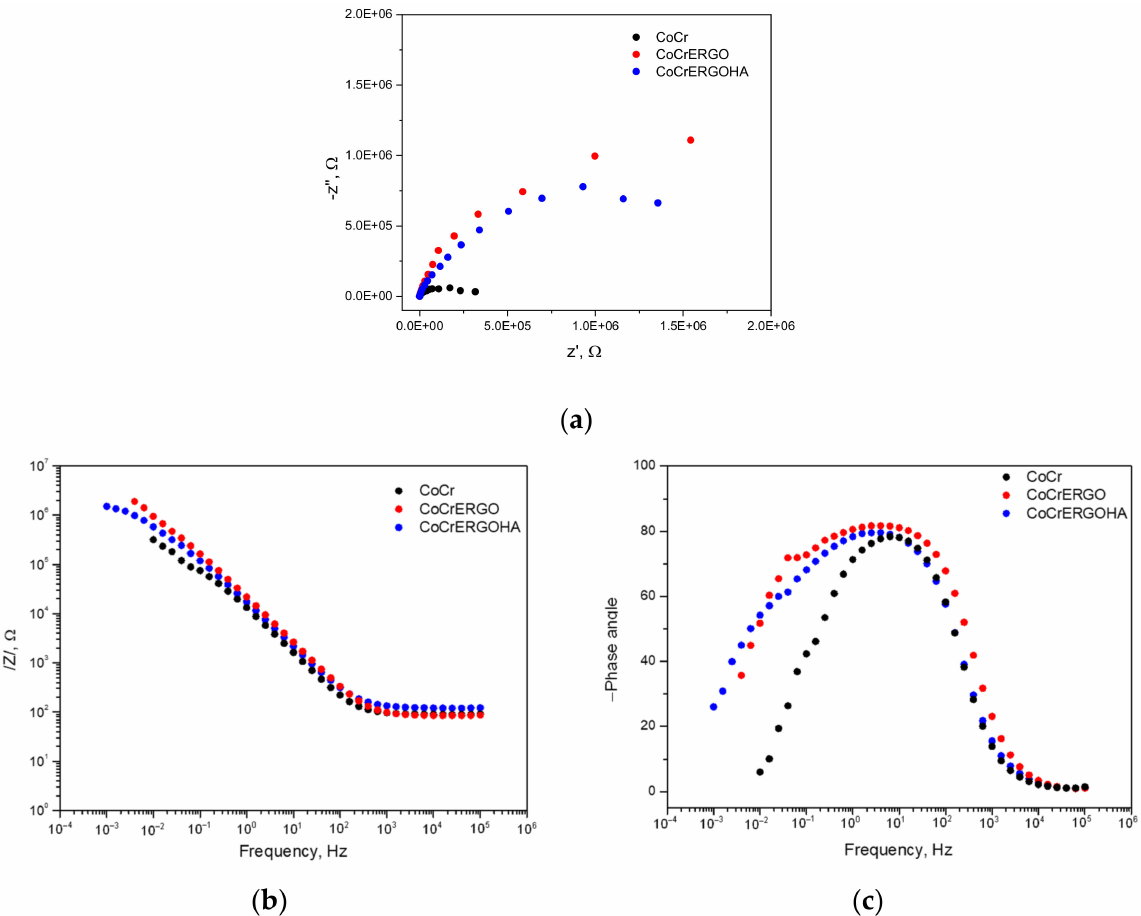
Figure 1. Nyquist diagrams ( a ) and Bode diagrams of impedance modulus ( b ) and phase angle ( c ) versus frequency, for CoCr, CoCrErGO, and CoCrErGOHA surfaces at 0 days of immersion in